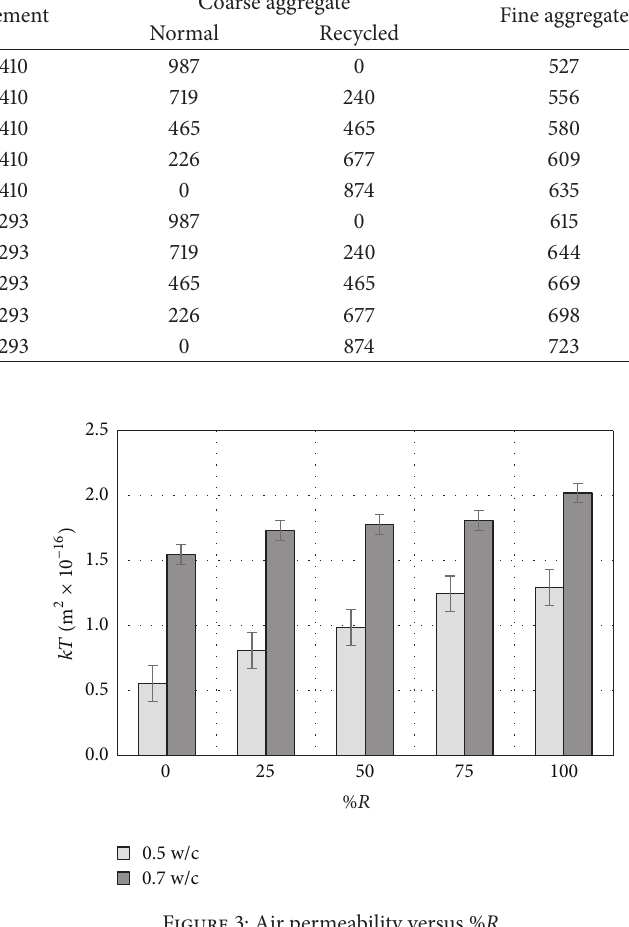
Figure 3: Air permeability versus % 𝑅 .